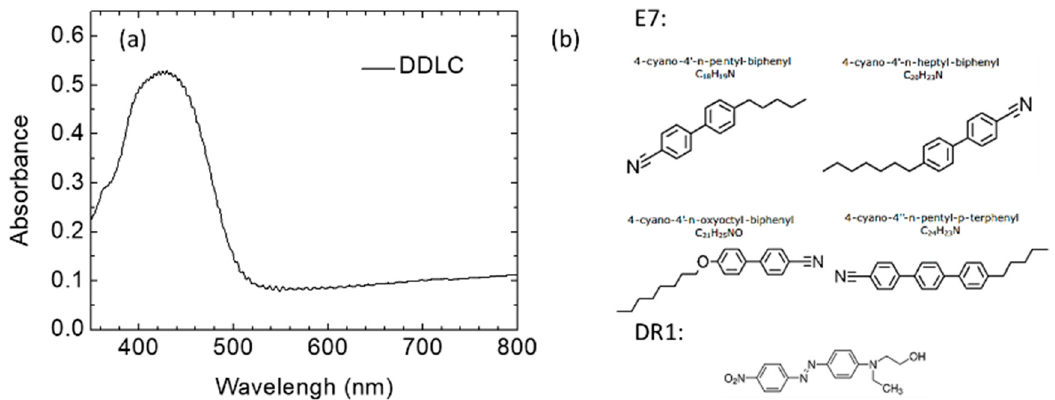
Figure 1. ( a ) The absorption spectra of the DDLC device. ( b ) Chemical structure of the dye-doped liquid crystal (DDLC) compound.